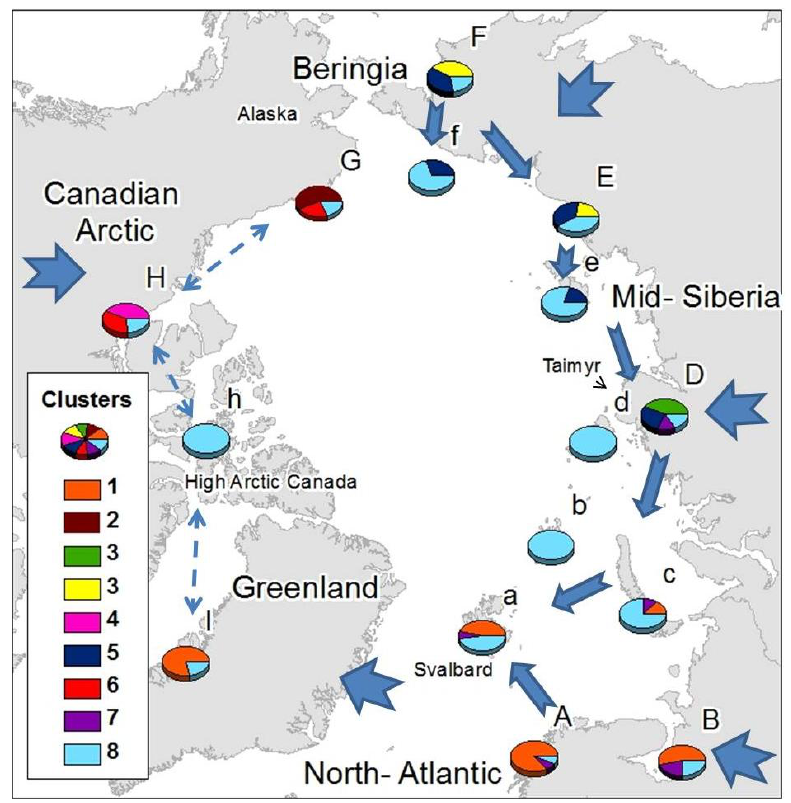
Figure 2. Gaussian mixture clustering geographically represented as number of species allocated to each cluster at each Arctic area. Arrows represent suggested dispersal routes to (thick arrows) and within (thin arrows) Arctic areas. Dashed arrows indicate areas of unresolved main dispersal routes.